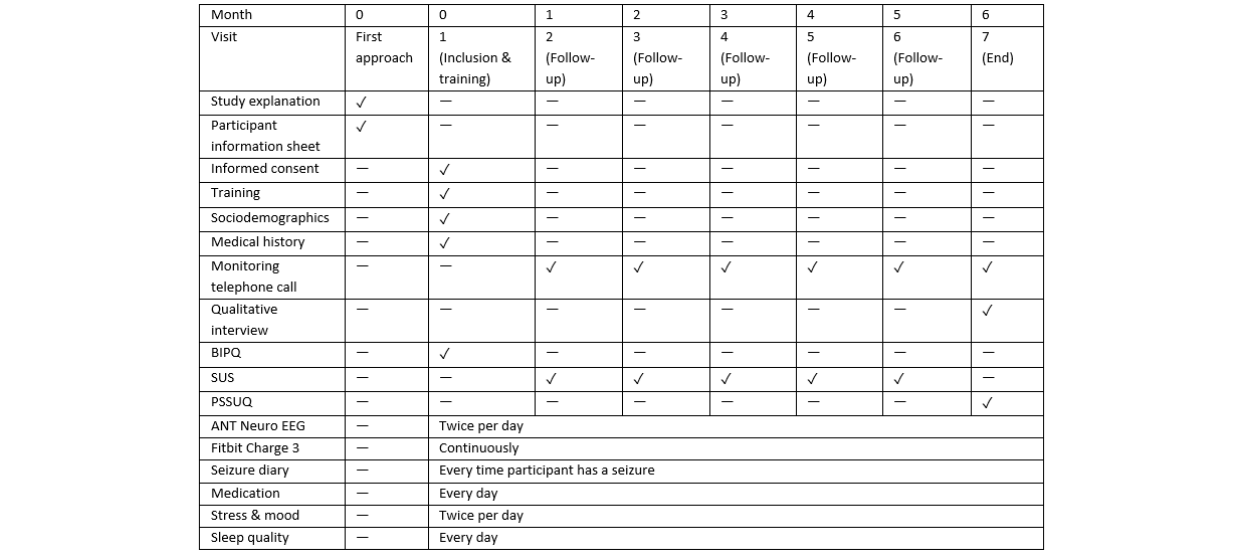
Figure 1. Schedule of events in the EEG@HOME study. BIPQ: Brief Illness Perception Questionnaire; EEG: electroencephalography; PSSUQ: